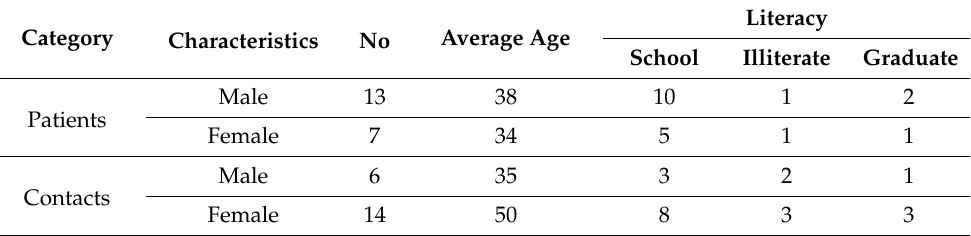
Table 1. Demographic details of